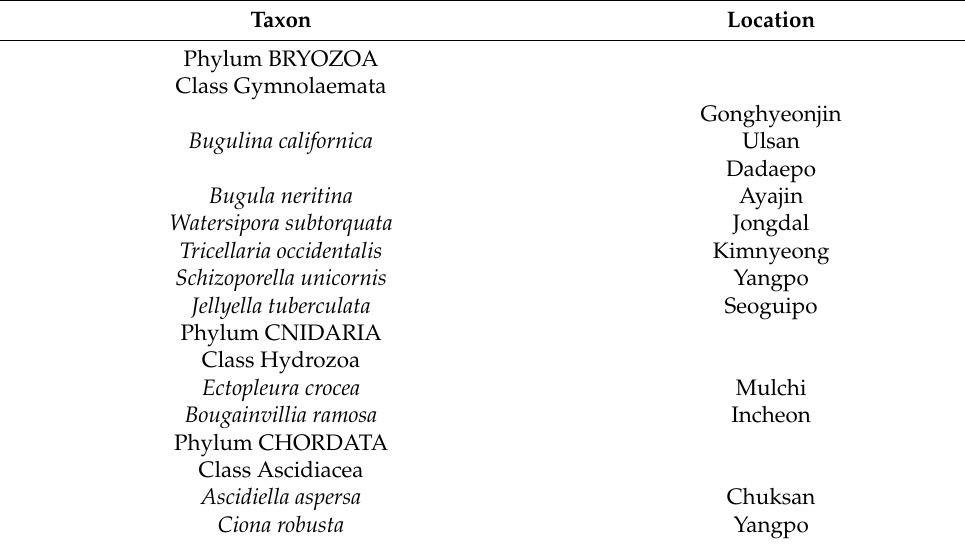
Table 3. List of invertebrate species shared habitat with B. californica used for determination of specificity of species-specific